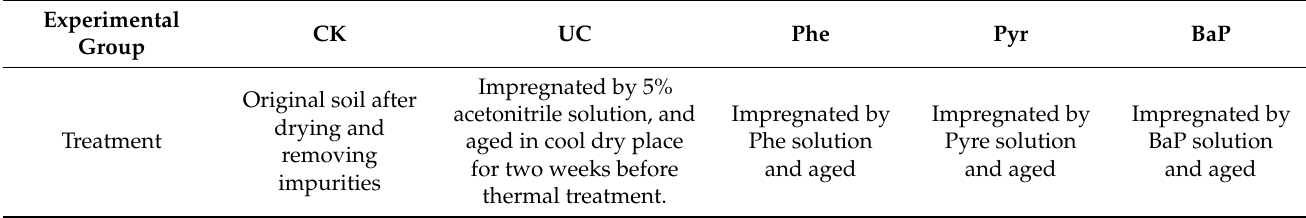
Table 3. Experimental group of the thermal remediation treatment.